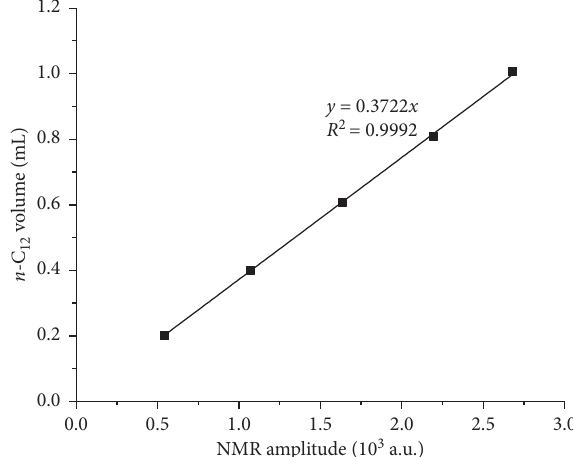
Figure 6: Relationship between NMR amplitude and n -C volume.